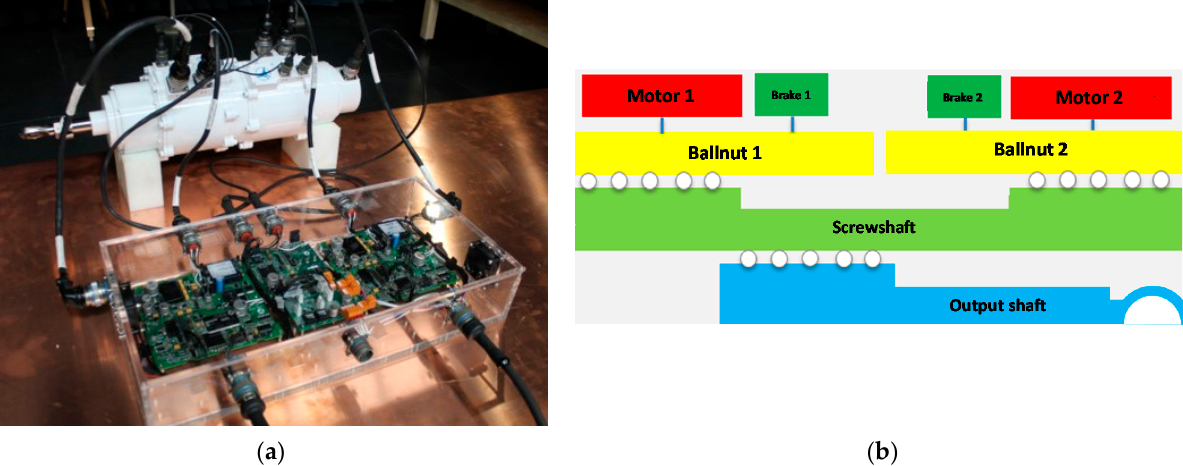
Figure 1. Fault-tolerant EMA by Umbragroup: ( a ) prototype on the test rig; ( b ) patented kinematic concept.